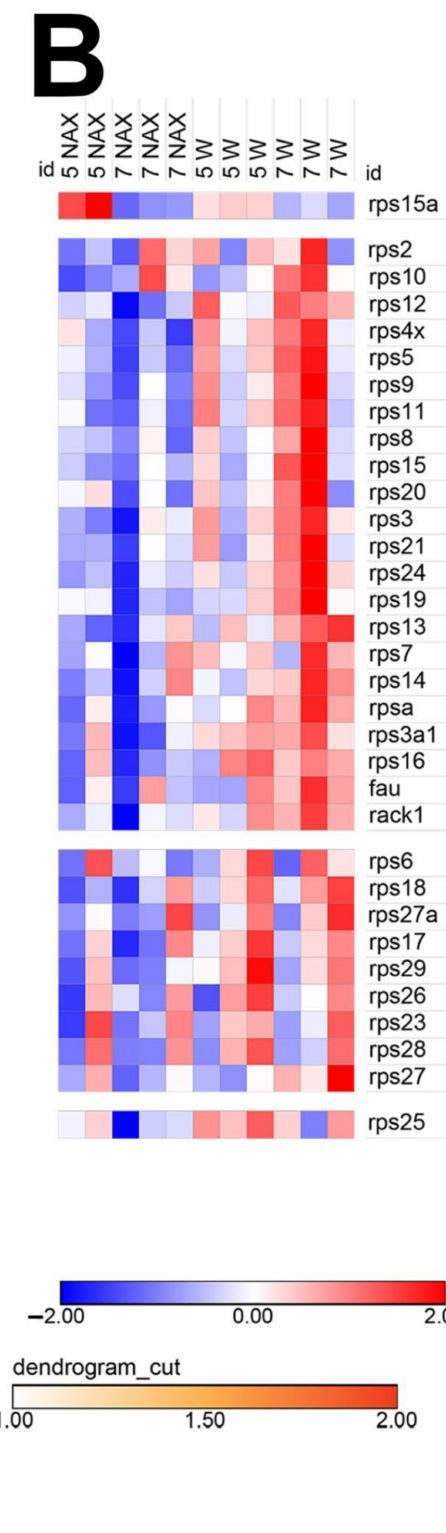
Figure 9. Heat map analysis of ribosomal protein gene expression in the nax cerebellum at P5/P7. The rows of the heat map represent the genes of interest and the columns represent the experimental samples. Each cell is colored based on the level of expression of that gene in that sample. This heat map analysis shows color-coded expression levels of up (red)- and down (blue)-regulated genes. The data show that major clusters of genes coding for large (RPL), ( A ) and small ribosomal subunits (RPS), ( B ) are markedly downregulated in the nax